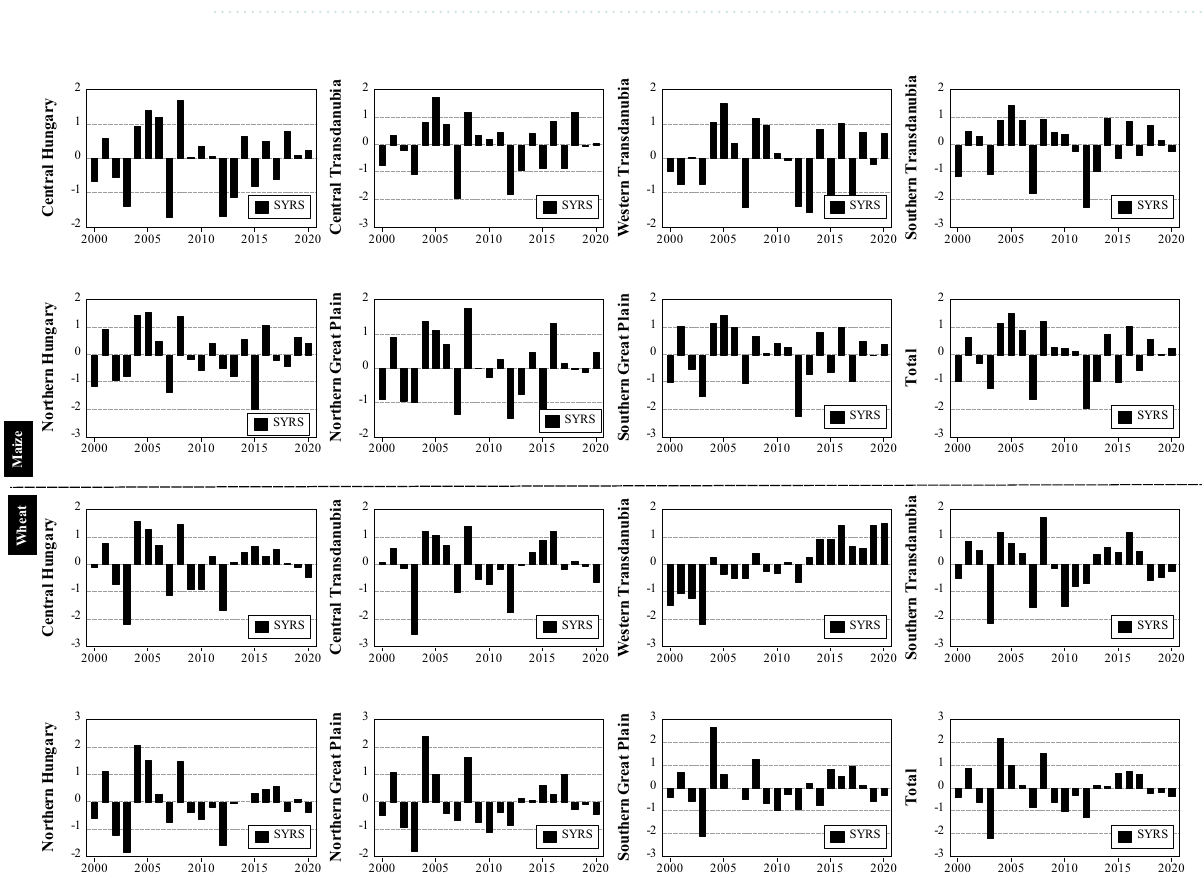
Figure 10. Temporal change in SYRS for both maize (up) and wheat (down) across Hungarian regions (2000– 2020) (figure was generated using EViews (https:// www. eviews. com/ home.